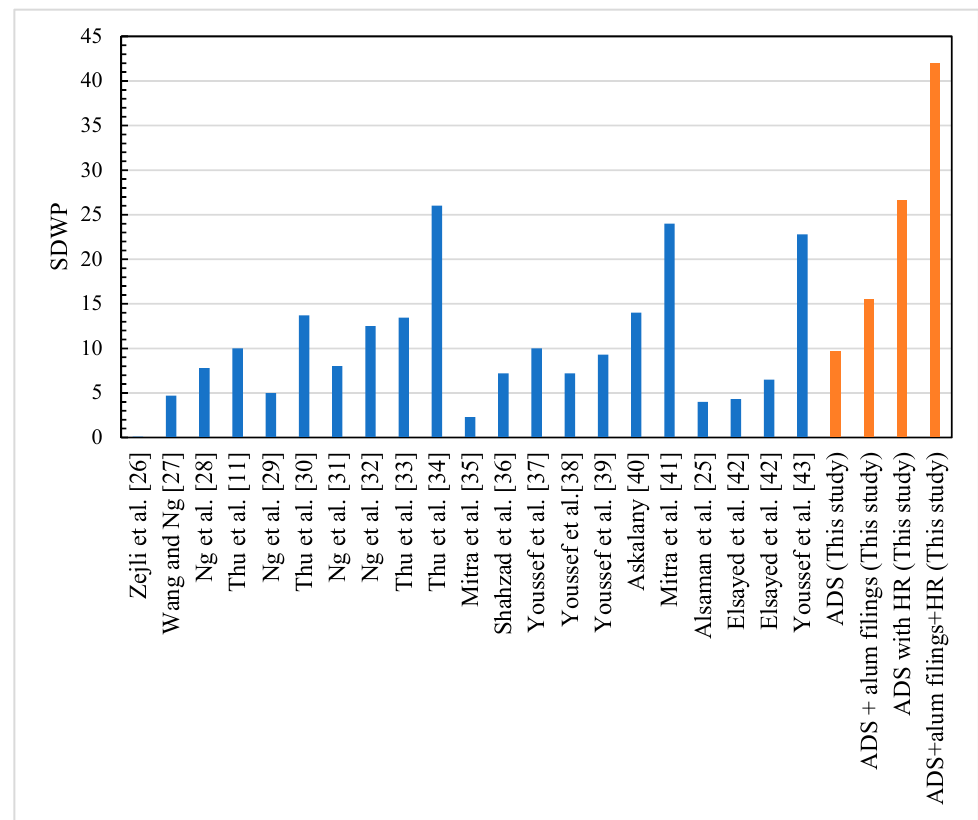
Figure 6. A comparison between the results of this study and previous studies according to the presented SDWP [26–43].